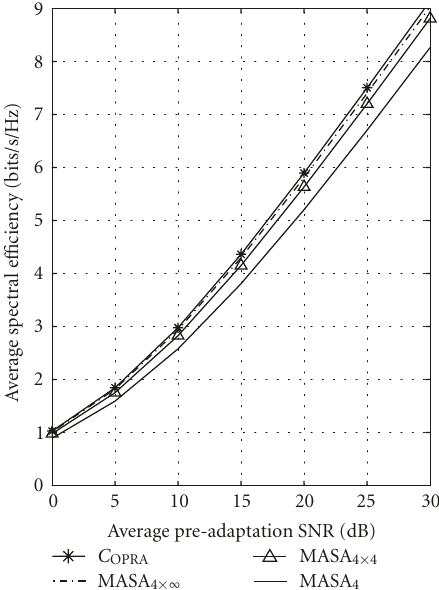
Figure 6: Average spectral e ffi ciency for various MASA schemes with N = 4 codes as a function of γ . C OPRA as reference [15] ( c (cid:2) 2006